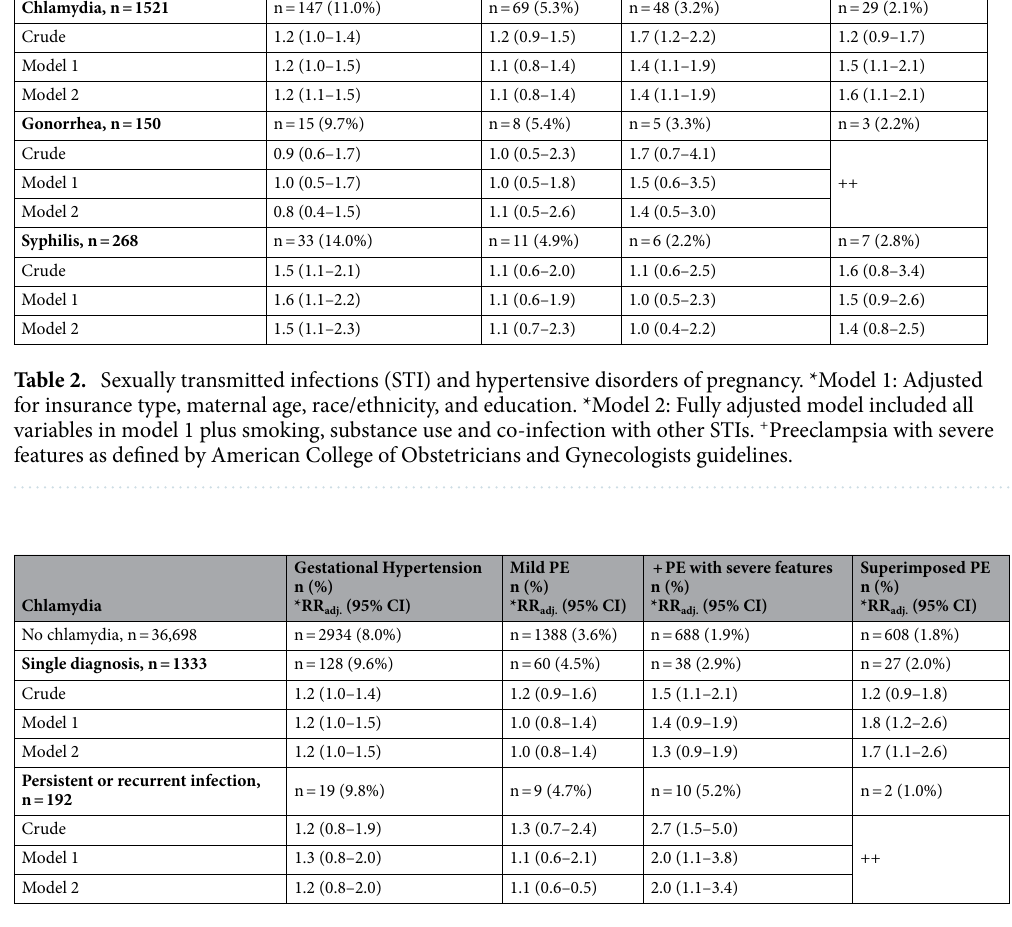
Table 3. Chlamydia trachomatis and risk of hypertensive disorders of pregnancy by single diagnosis and persistent or recurrent infection. Single diagnosis refers to women diagnosed at the first prenatal visit only, persistent or recurrent infection refers to an additional diagnosis recorded after repeat testing. *Model 1: Adjusted for insurance type, maternal age, race/ethnicity, and education. *Model 2: Fully adjusted model included all variables in model 1 and smoking, substance use and co-infection with other STIs. + Preeclampsia with severe features as defined by American College of Obstetricians and Gynecologists